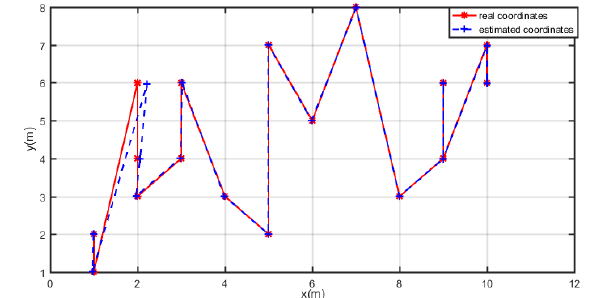
Fig. 3. Localization of 20 points using initialization 1.